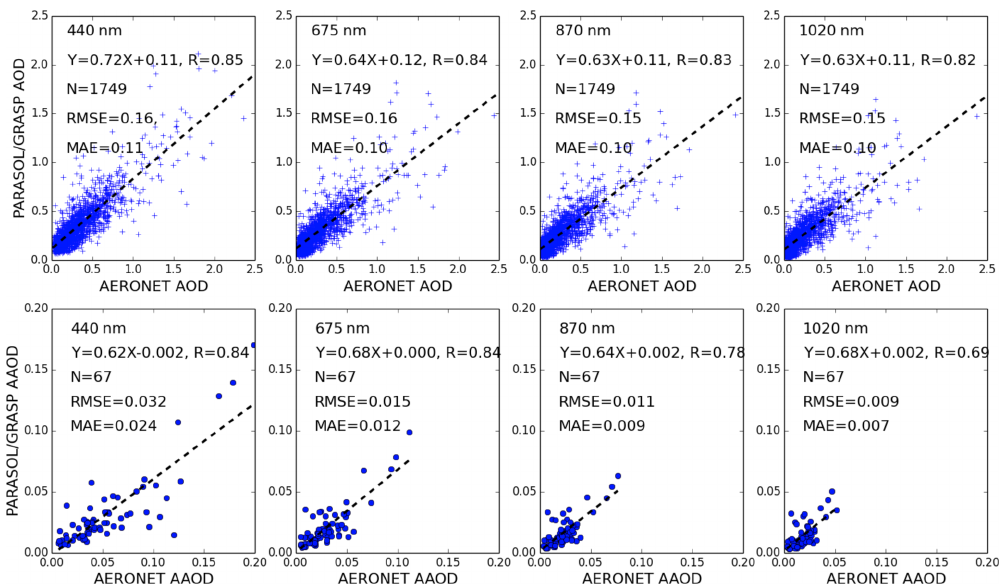
Figure 3. Validation of 1 year of PARASOL/GRASP spectral AOD and AAOD re-scaled to 2.0 ◦ × 2.5 ◦ horizontal resolution with 28 AERONET site measurements at 440, 675, 870 and 1020nm wavelengths over the study area; the number of matched pairs ( N ), correlation coefficient ( R ), root-mean-square error (RMSE) and mean absolute error (MAE) are provided in the top left